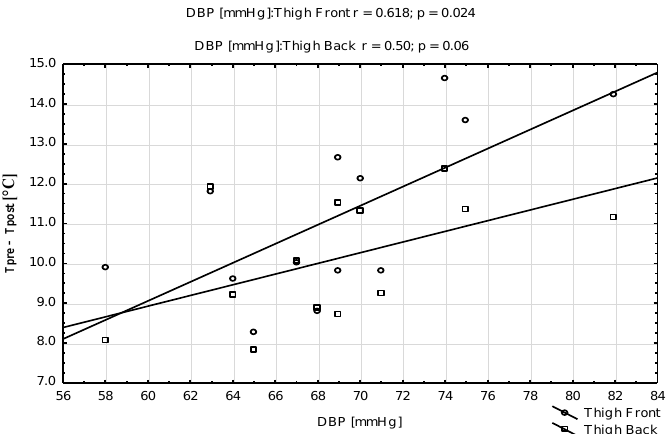
Figure 9. Relationship between diastolic blood pressure and the magnitude of change in temperature of the anterior and posterior surfaces of the thighs.